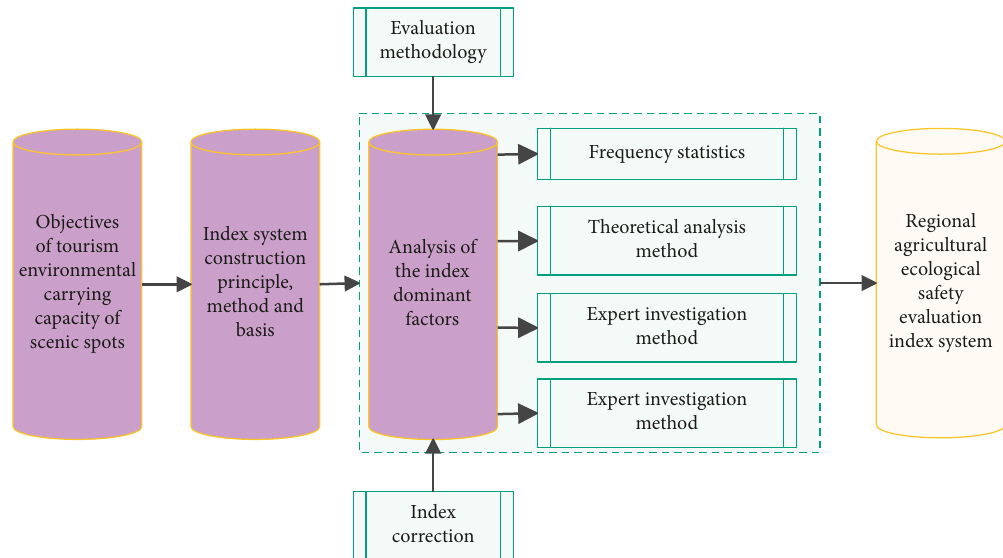
Figure 5: Evaluation index system of tourism environment carrying